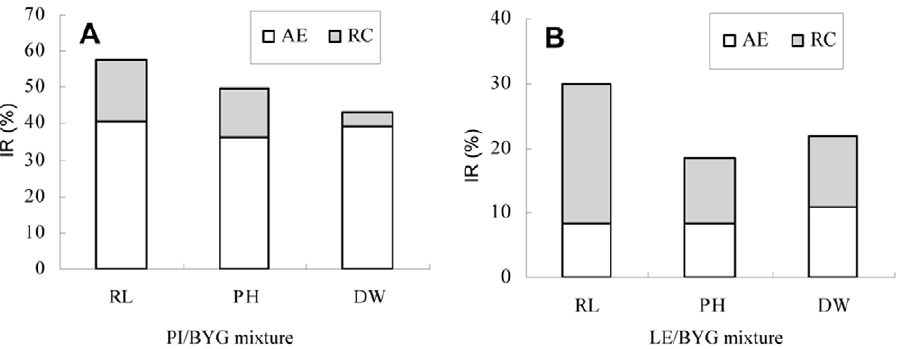
Figure 2. Separation of resource competition (RC) and allelopathic effect (AE) in rice/BYG mixed-cultures. A – Inhibitory rate (IR) of PI on BYG in PI/BYG mixture. B – Inhibitory rate (IR) of LE on BYG in LE/BYG mixture. TB – total biointerference. RC – resource competition. AE – allelopathic effect. TB (total bars)=RC (shaded bars) + AE (open bars). RL – root length; PH – plant height; DW – plant dry weight. PI – rice accession PI312777; LE – rice accession Lemont. BYG –